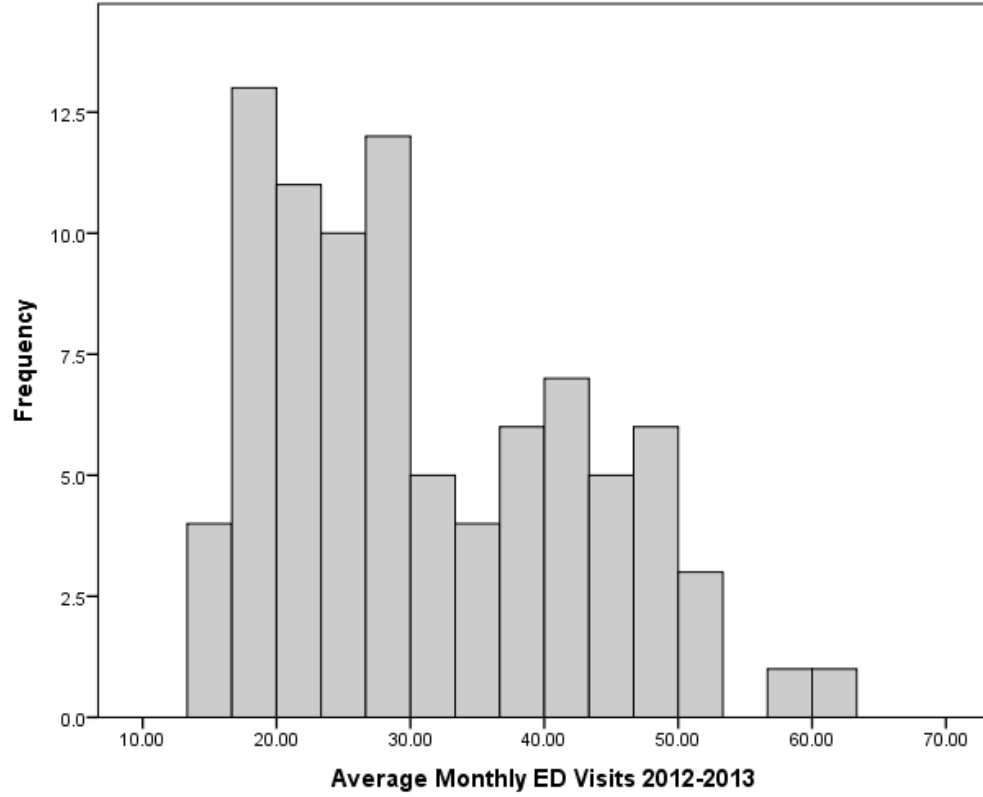
Table. Correlations between changes in insurance coverage for residents age 18-64 and changes in average monthly emergency department (ED) visits between 2012-13 and 2014-15 across 88 Public use micro areas in Illinois.